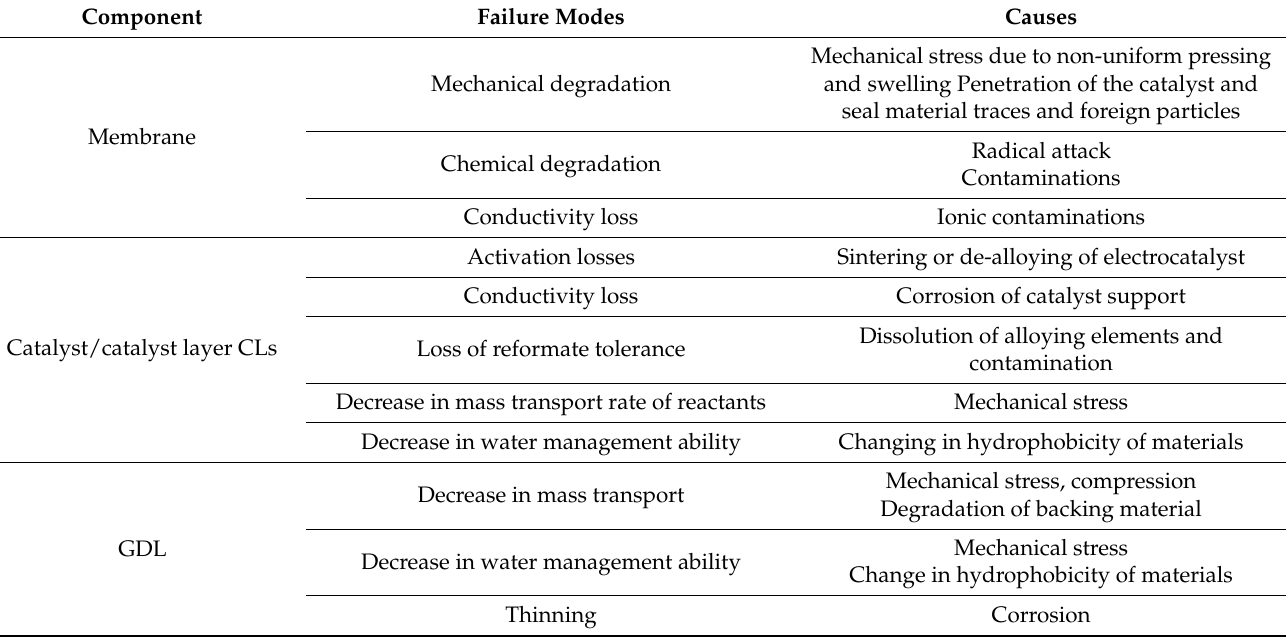
Table 1. The major failures of components in a polymer electrolyte membrane fuel cell (PEMFC) [19,84].